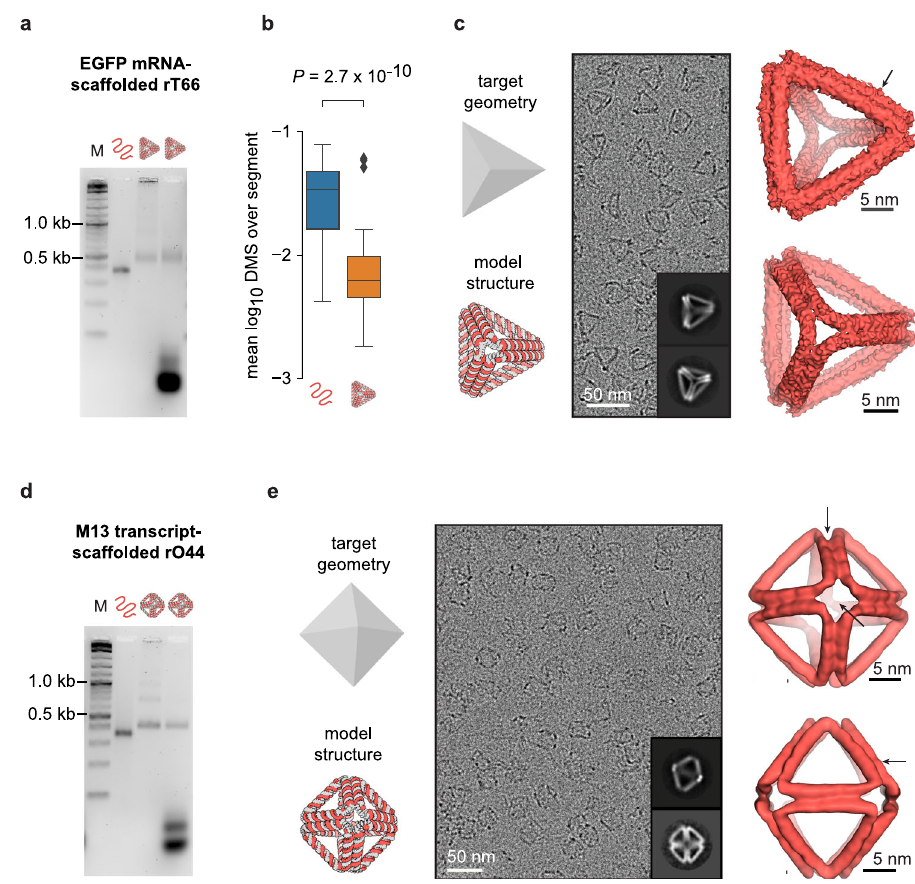
Fig.2|CharacterizationofEGFPmRNA-andM13RNA-scaffoldedorigami.a Gel mobility shift assay, left to right: marker (1kb plus DNA ladder, NEB), EGFP mRNA scaffoldwithoutDNAstaples,spin fi lter-puri fi edfoldedrT66,andunpuri fi edfolded rT66, n =1 replicate. No scaffold band appears in the folded particle lane, sug- gesting 100% folding yield. b Box plots showing, for each unbroken segment of RNA:DNA duplex in rT66 ( n =64 segments), the mean DMS reactivity among ade- ninesandcytosinesinthesegment ’ sRNAscaffoldstrand(right,orange)compared withthesameadeninesandcytosinesintheRNAstrandfoldedwithoutDNAstaples (left, blue), n =1 replicate. Each box plot depicts the median (middle line), 1st and 3rd quartiles (box), minimum/maximum up to 1.5 interquartile ranges from box (whiskers), and outliers (grey diamonds). The P -value indicates the signi fi cance of